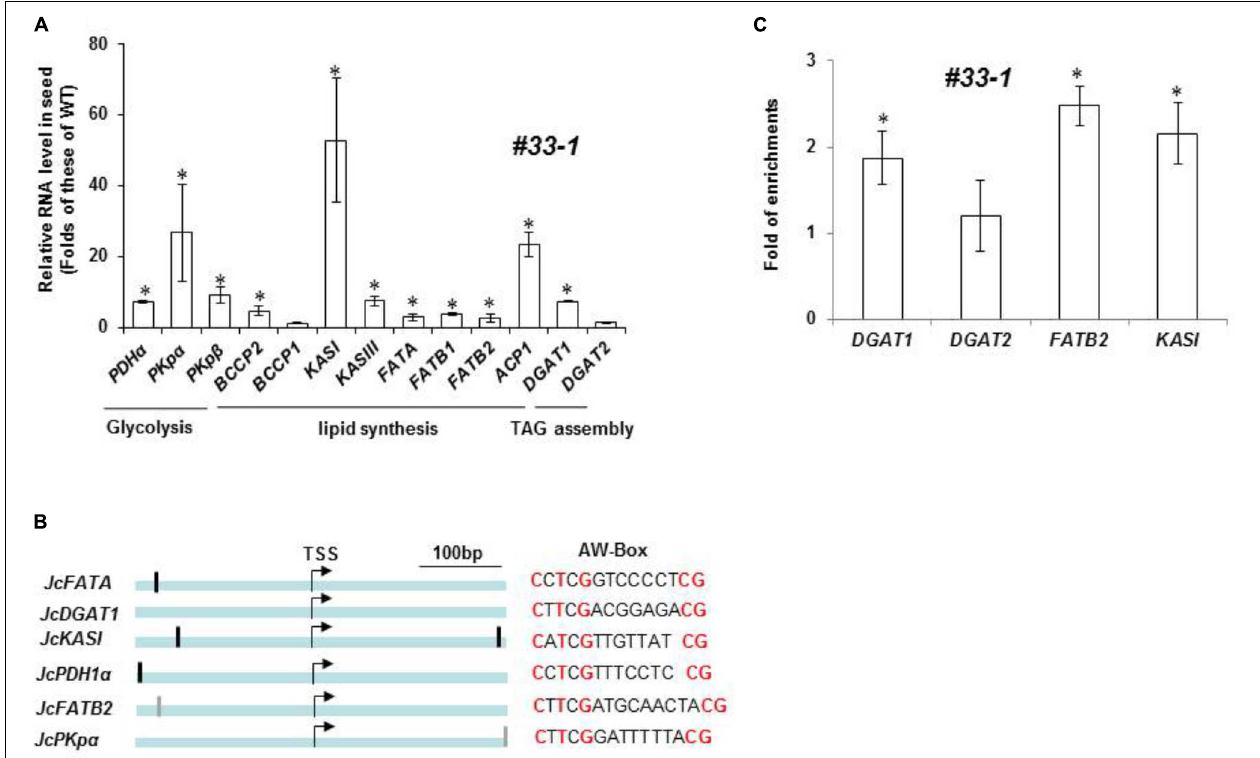
FIGURE 7 | Genes involved in lipid biosynthesis and assembly pathways are differentially regulated by JcWRI1 . (A) Expression levels of lipid biosynthesis pathway genes in endosperm of J. cucas plants overexpressing JcWRI1 line #33-1. The Jatropha Ubiquitin transcript served as an internal control for all RNA samples. The value was presented as fold of the level in #33-1 against WT control (mean ± SD, n = 3) with statistical analysis by Student’s t -test ( ∗ indicates p < 0.05). (B) Diagram of gene structure of AW-box containing promoters. Dark bars in promoter regions indicate AW-box and gray bars indicate AW-like box. Bar: 100 bp. (C) Identification of direct target genes of JcWRI1 by Chromatin immunoprecipitation (ChIP) assay with WRI1 antibody. Developing J. curcas endosperm (six WAF) was harvested for ChIP assays. The fold enrichment was expressed relative to JcTubulin2 which was used as an internal control. Amplification levels obtained with the individual primer pair served as background signal of JcWRI1 binding. The experiment was repeated twice with similar results. Values are mean ± SD of three technical replicates with statistical analysis by Student’s t -test ( ∗ indicates p <